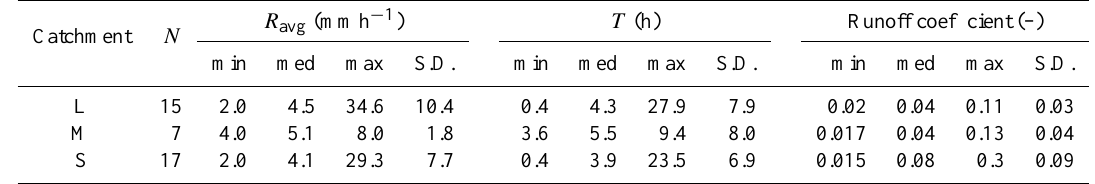
Table 5. Characteristics of the rainstorm events selected for evaluation of closure relations. Catchment N